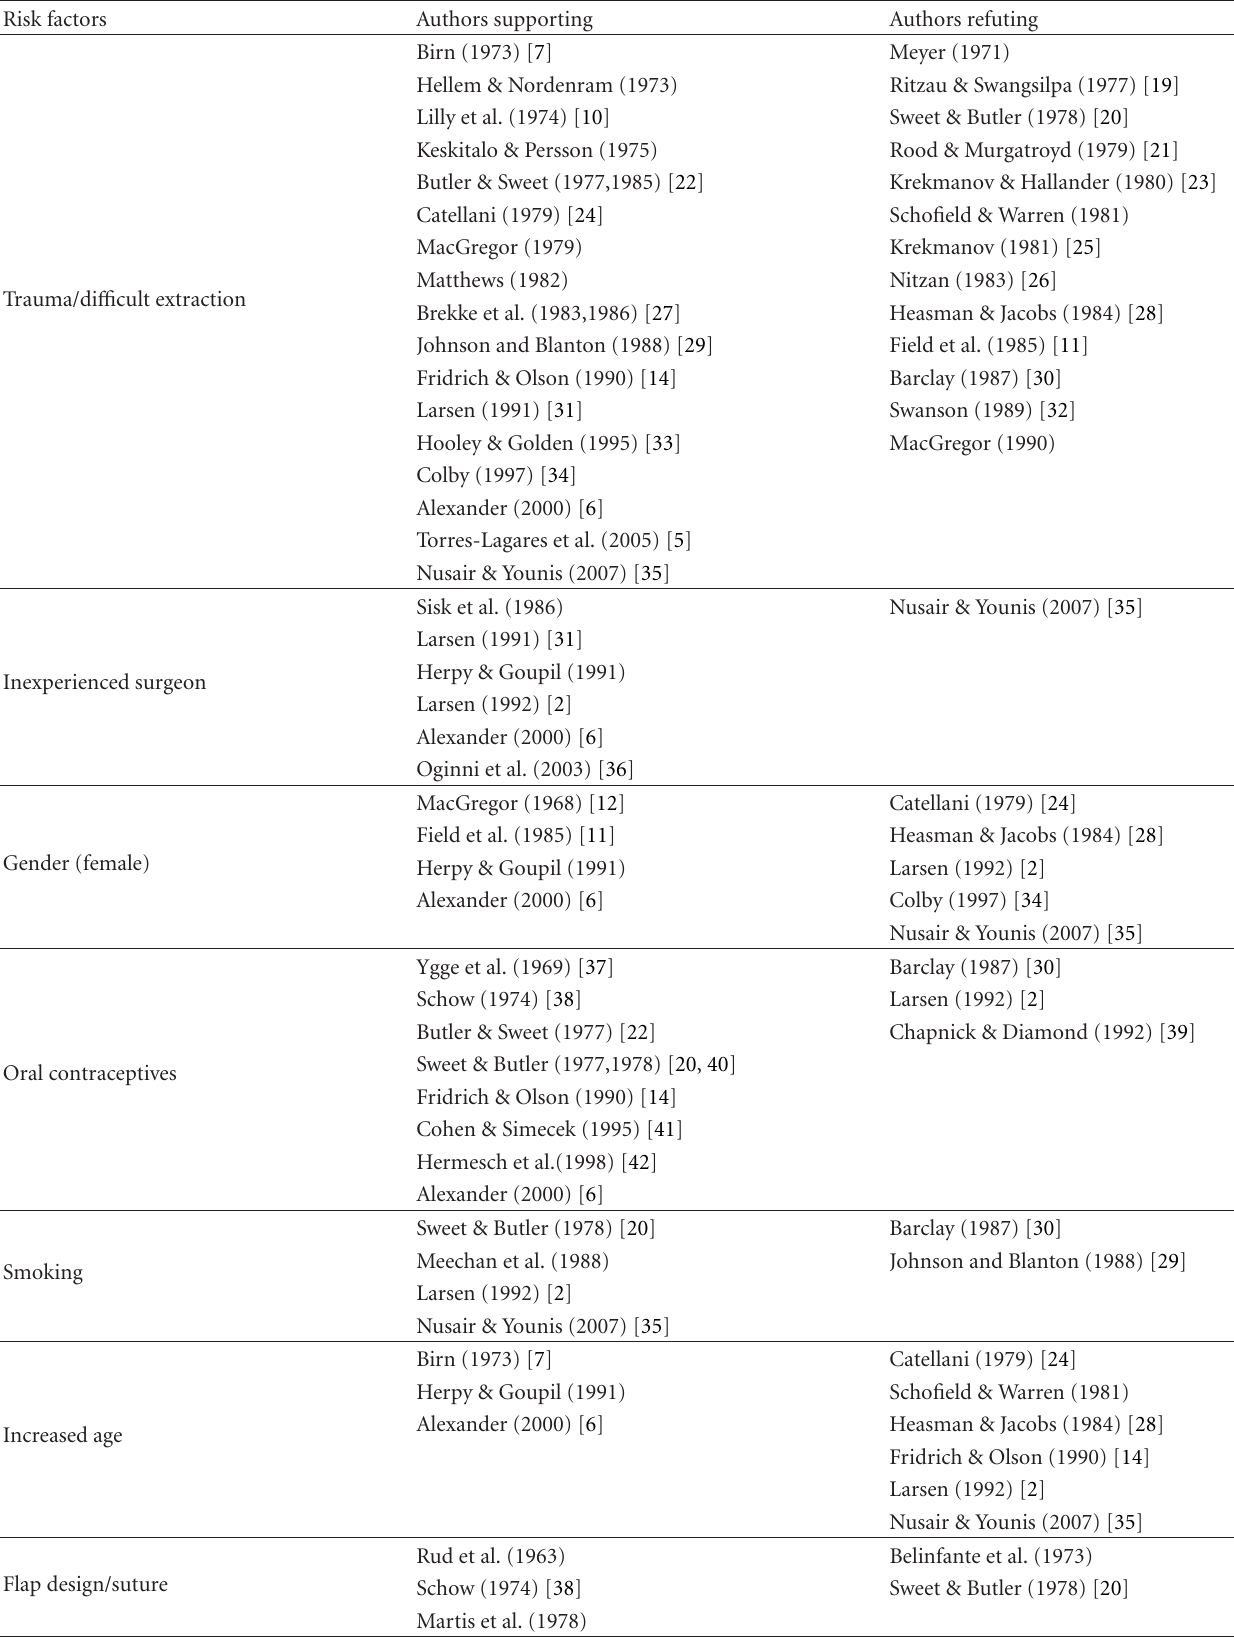
Table 1: Proposed risk factors and associated